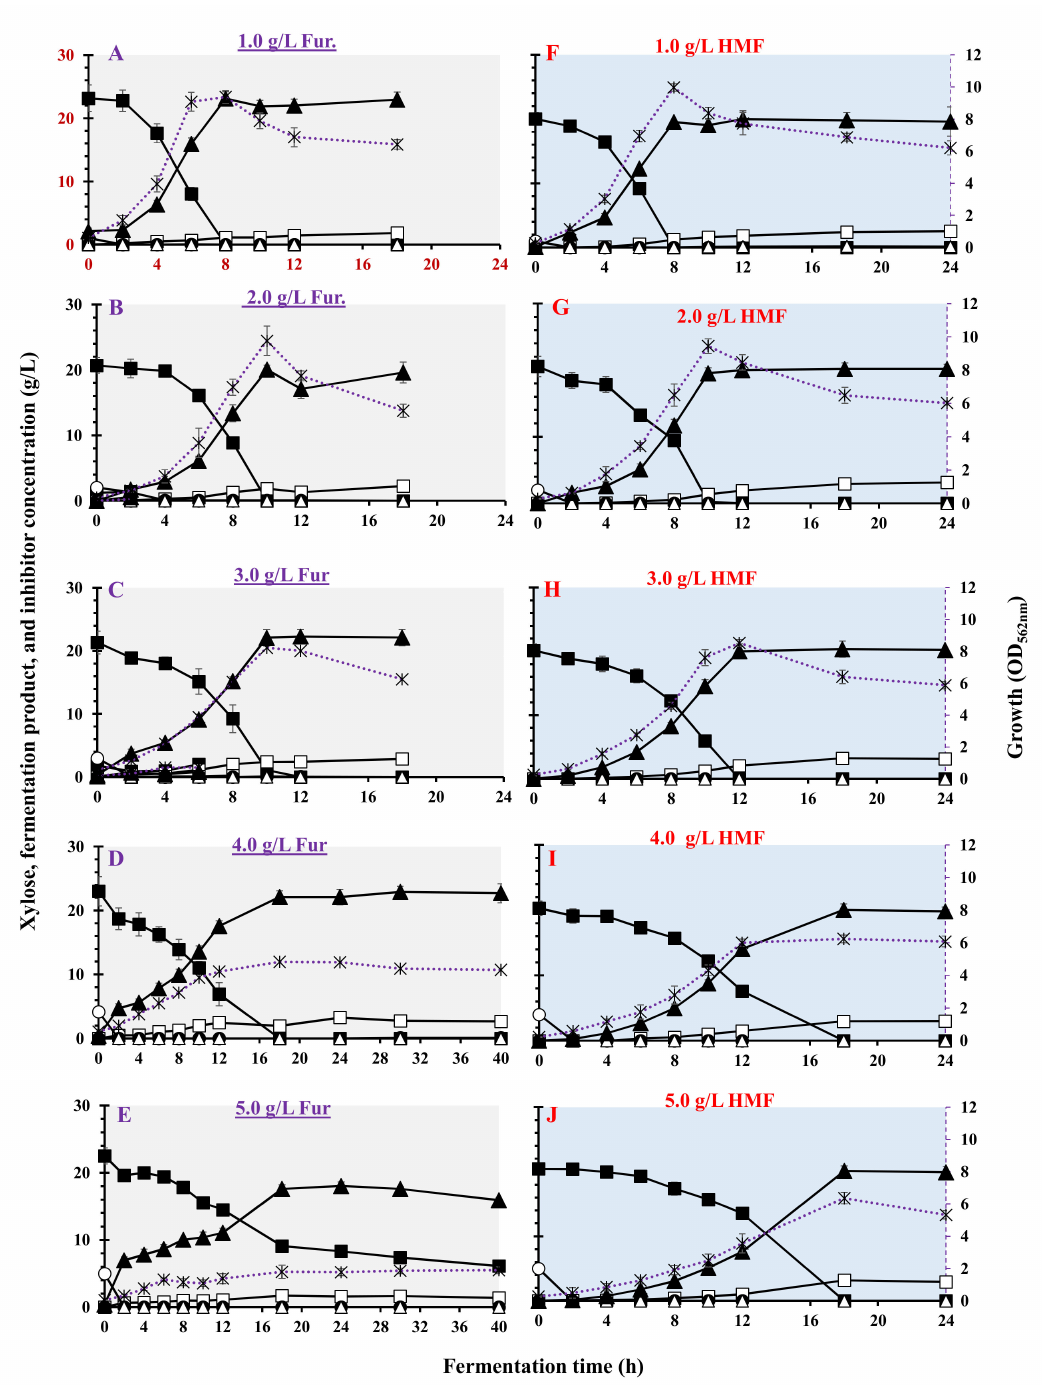
Figure 1. Effect of different concentrations of furfural ( A – E ) and HMF ( F – J ) on the growth and lactic acid production by Bacillus coagulans Azu-10. Symbols: (cid:4) , xylose (g/L); (cid:3) , acetic acid (g/L); (g/L); ∆ , ethanol (g/L); (cid:78) , lactic acid (g/L); *, growth (OD 562nm ). The standard deviation is less than the size of symbols if no error bars are